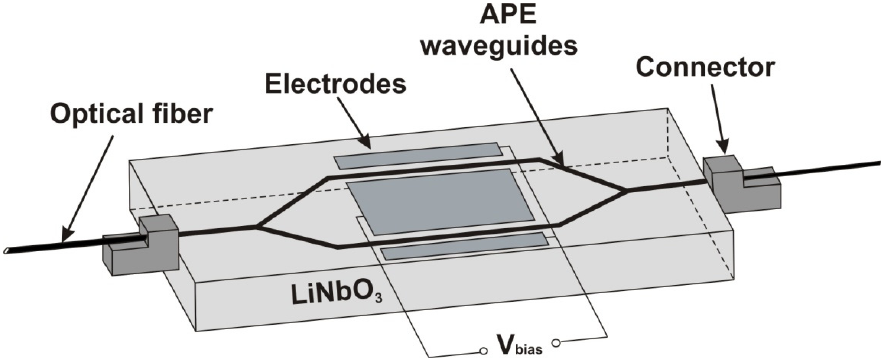
Figure 1. Schematic of